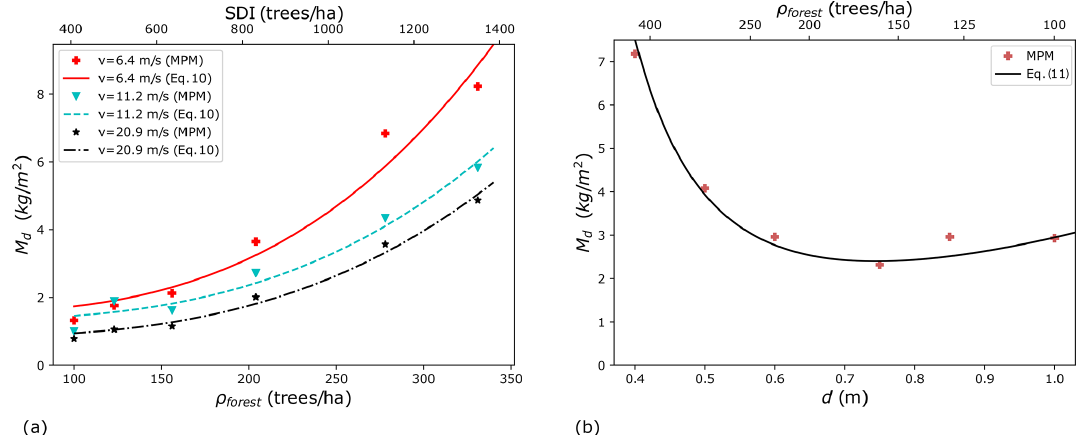
Figure 9. (a) Evolution of the detrainment mass per unit of area with the forest density for different front velocities (regular staggered forest, snow properties: Case 2, d = 0 . 6m). (b) Evolution of the detrainment mass per unit of area with the tree diameter for a constant stand density